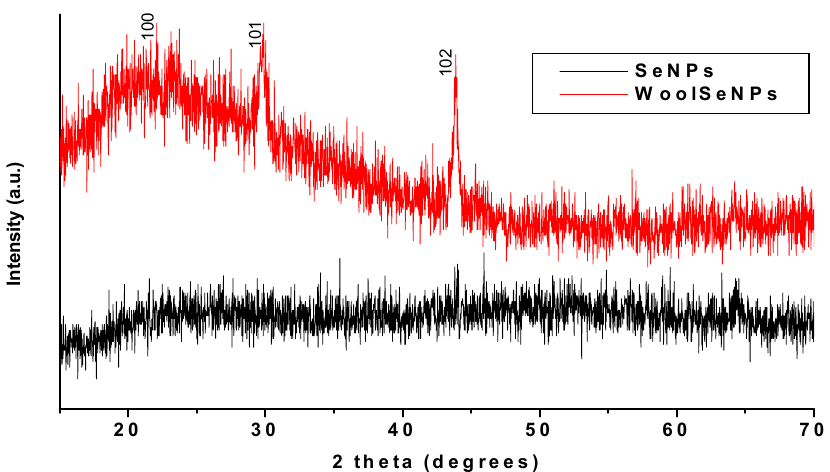
Figure 3. XRD patterns of the synthesized Se ‐ NPs and Se ‐ dyed wool fabric. Table 1. Antimicrobial activity of the Se-dyed wool fabrics at different temperatures. Se-NPs